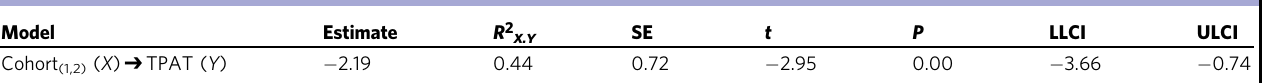
Table 3 Results of direct effect.